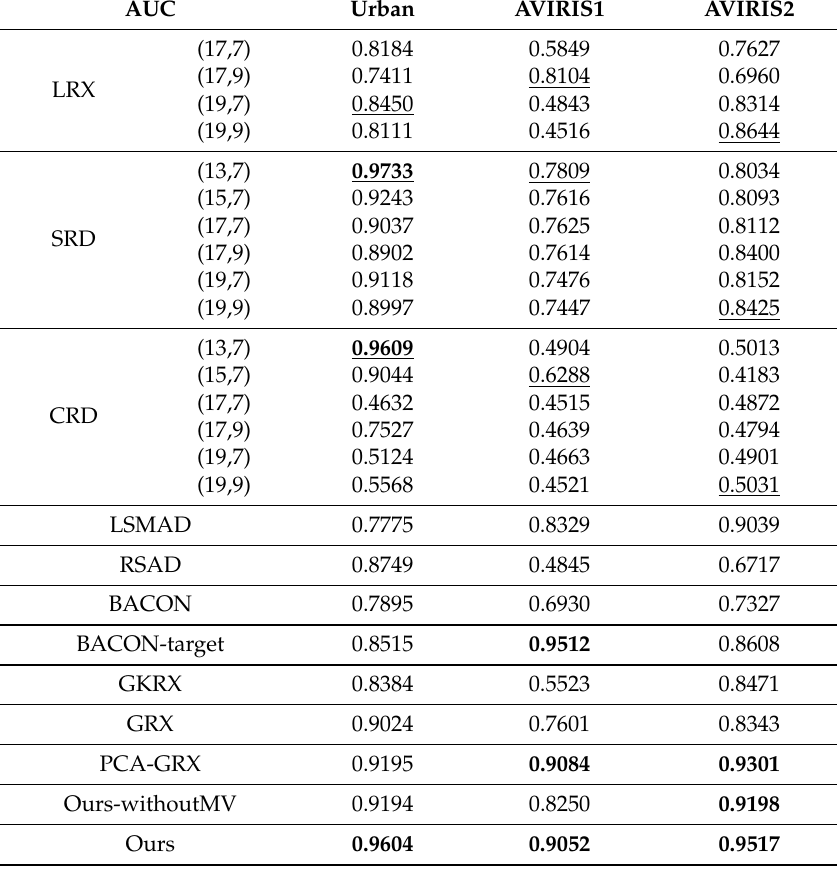
Table 1. AUC values of all the competitors on three hyperspectral images including Urban data set, AVIRIS1data set, and AVIRIS2 data set. The bold numbers represent the highest three results, and the underline marks the result under the optimal window